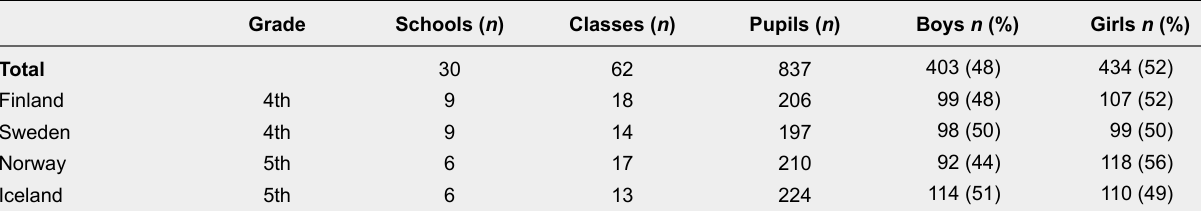
Number of Participating Schools, Classes, and Pupils in the ProMeal Study